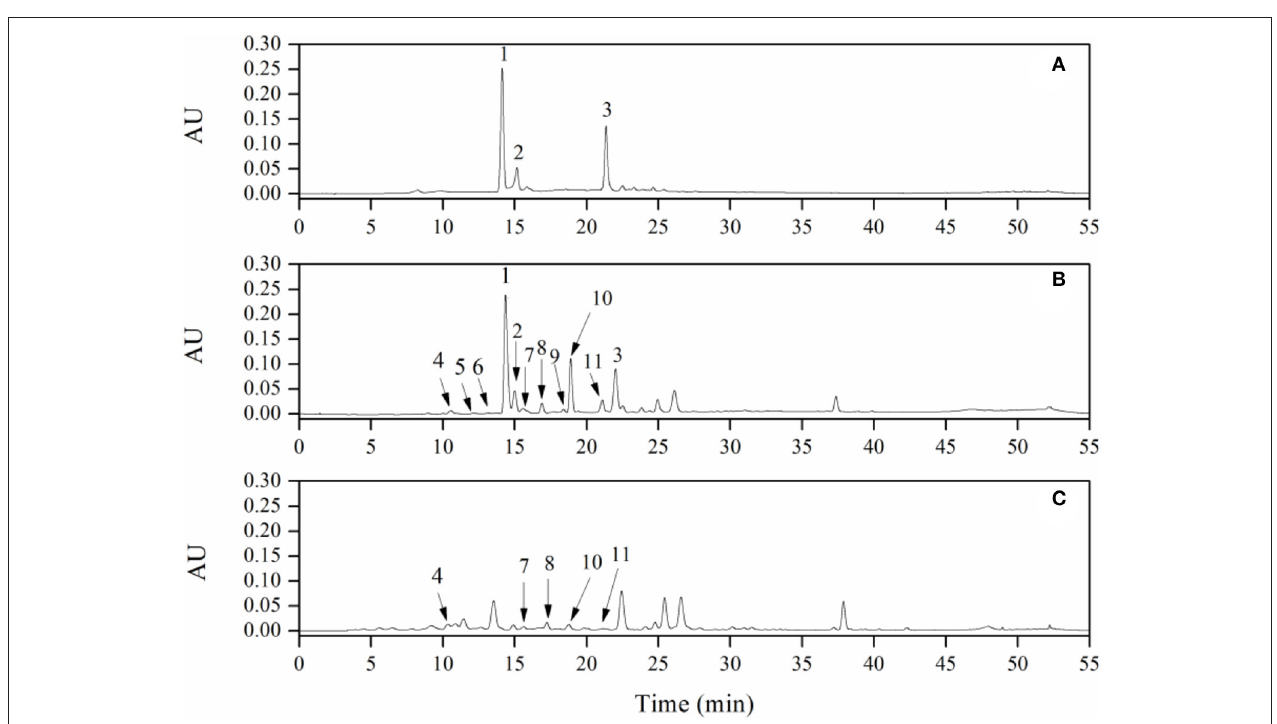
FIGURE 1 | RP-HPLC chromatogram of litchi pericarp (LPPC) ( A , 1 mg/ml) and their urinary metabolites in rats: (B) of experimental group with LPPC administration dose of 300 mg/kg · bw, (C) of control group (1, (-)-Epicatechin; 2, A-type trimer; 3, A-type dimer; 4, 3-hydroxyphenylacetic acid; 5, vanillic acid; 6, caffeic acid; 7, 3-hydroxyphenylpropionic; 8, p -coumaric acid; 9, shikimic acid; 10, 4-hydroxyphenylpropionic acid; and 11, m -coumaric